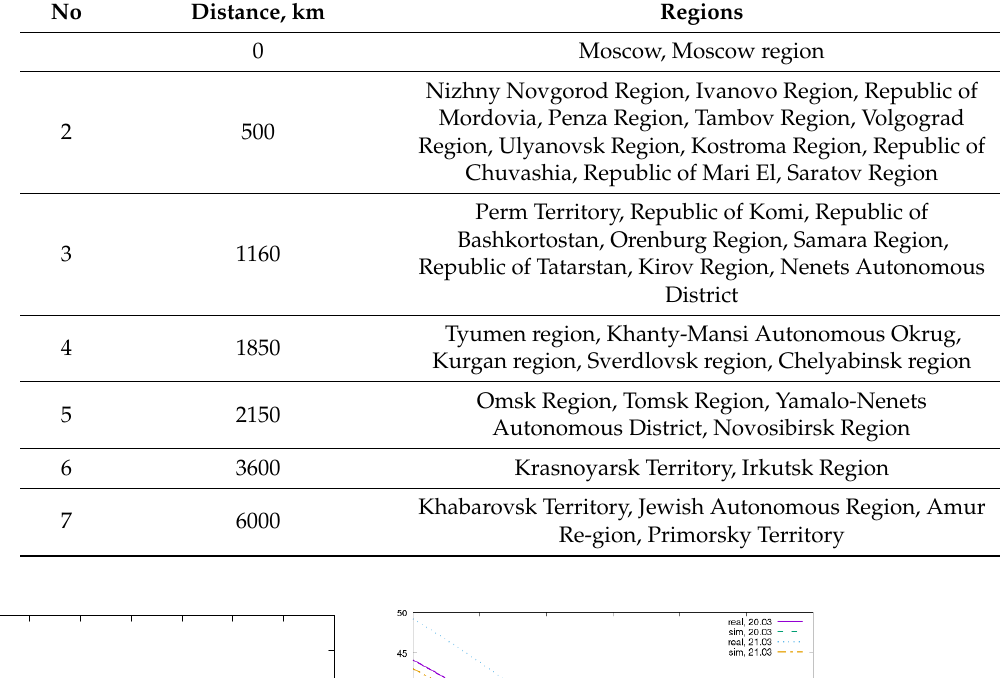
Table 4. Regions to bands correspondence in Russia.